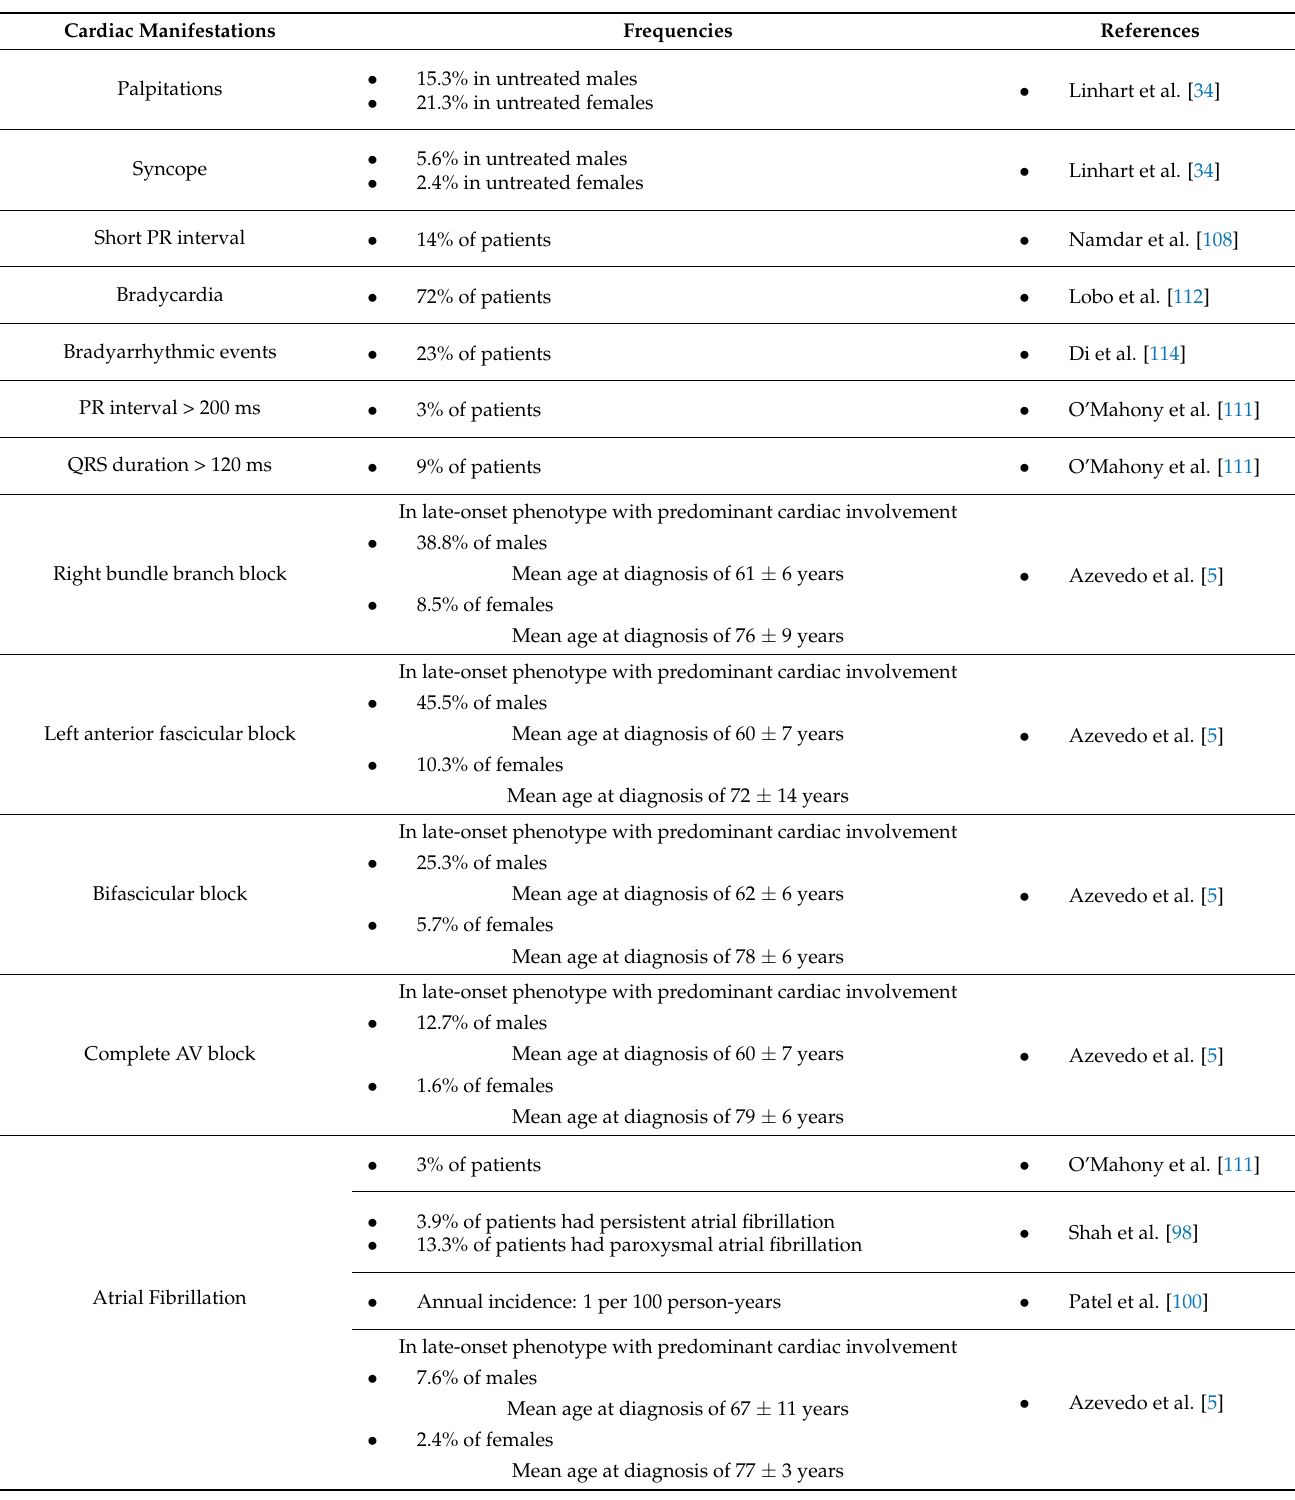
Table 3. Frequency of dysrhythmias and cardiac conduction disorders in